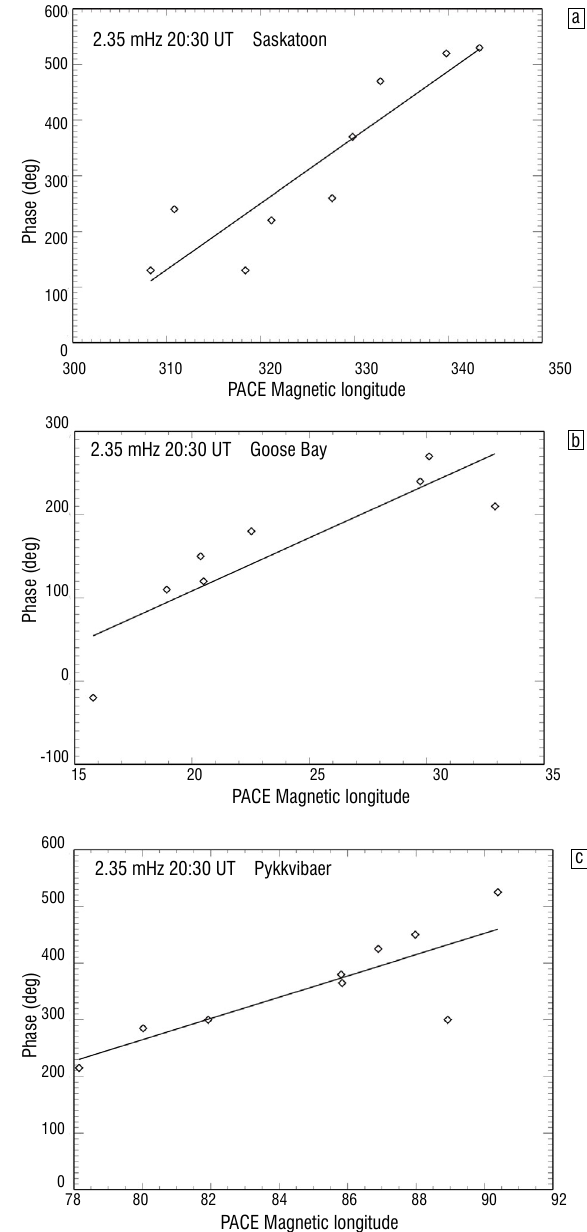
Figure 10: Plot of phase versus longitude measured at 20:30 UT for the 2.35-mHz frequency. The slope of these relations yields the azimuthal wave number, m : (a) 12±2.1 for Saskatoon, (b) 13±2.9 for Goose Bay and (c) 19±5.0 for Þykkvibaer, corresponding to westward phase velocities at the ionosphere.